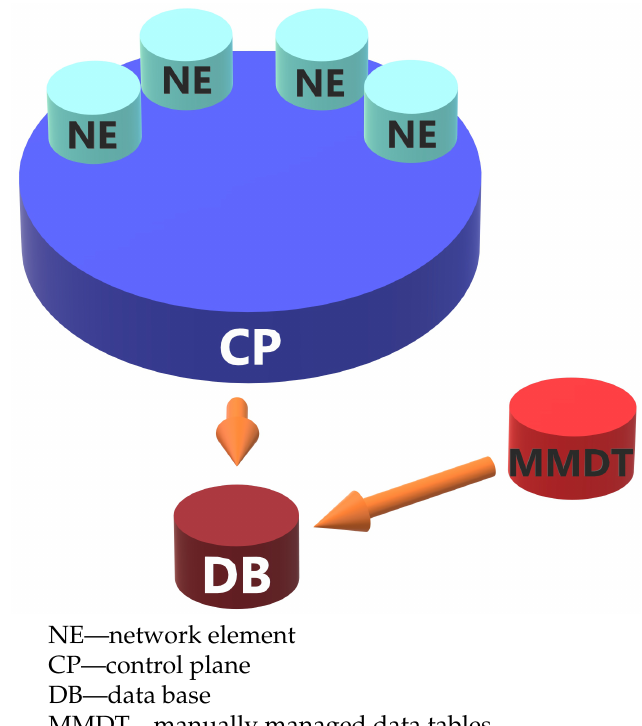
Figure 1. Data preparation